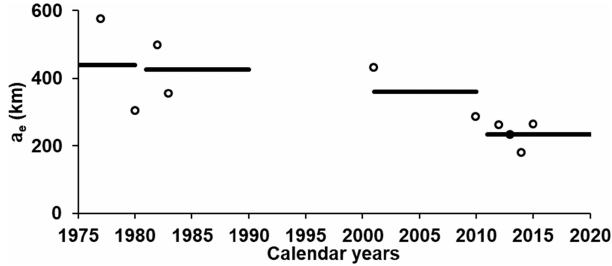
Figure 4. Effective ranges ( a e ) of the semivariograms used for krig- ing. Annual ranges are indicated by empty circles, and the decadal averages are indicated by horizontal black